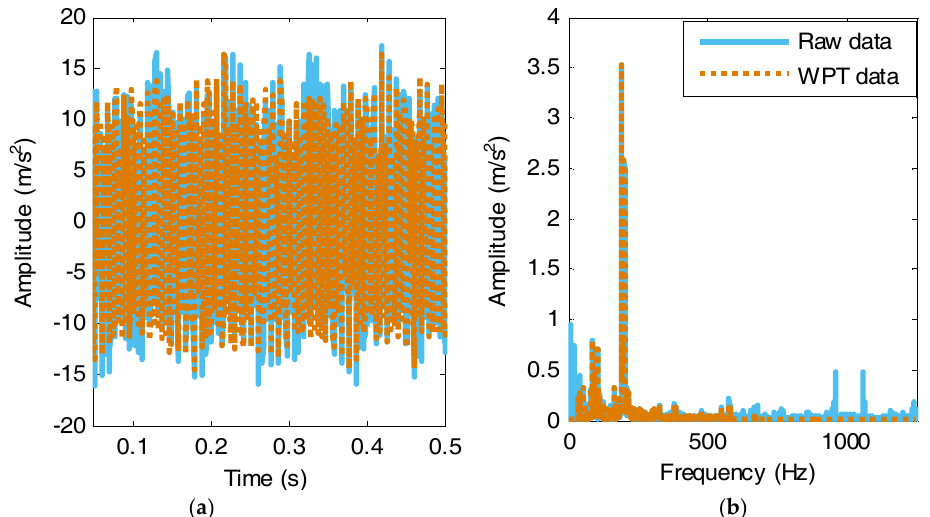
Figure 11. The comparison of the original signal and the reconstructed signal: ( a ) time domain; ( b ) frequency domain.